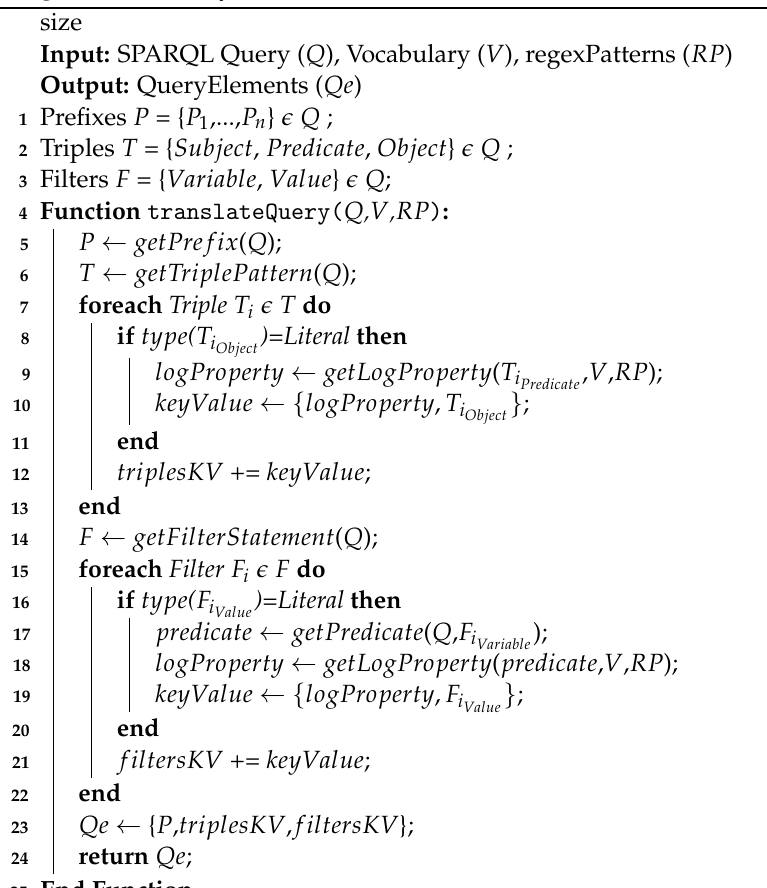
Algorithm 1: Query translation.